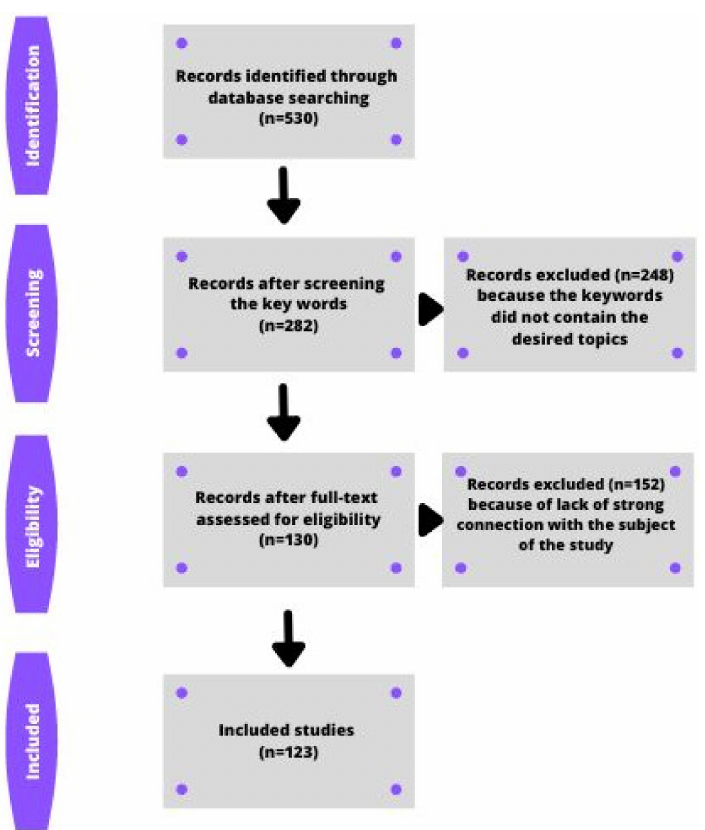
Figure 1. Flow-chart explaining the process of selecting